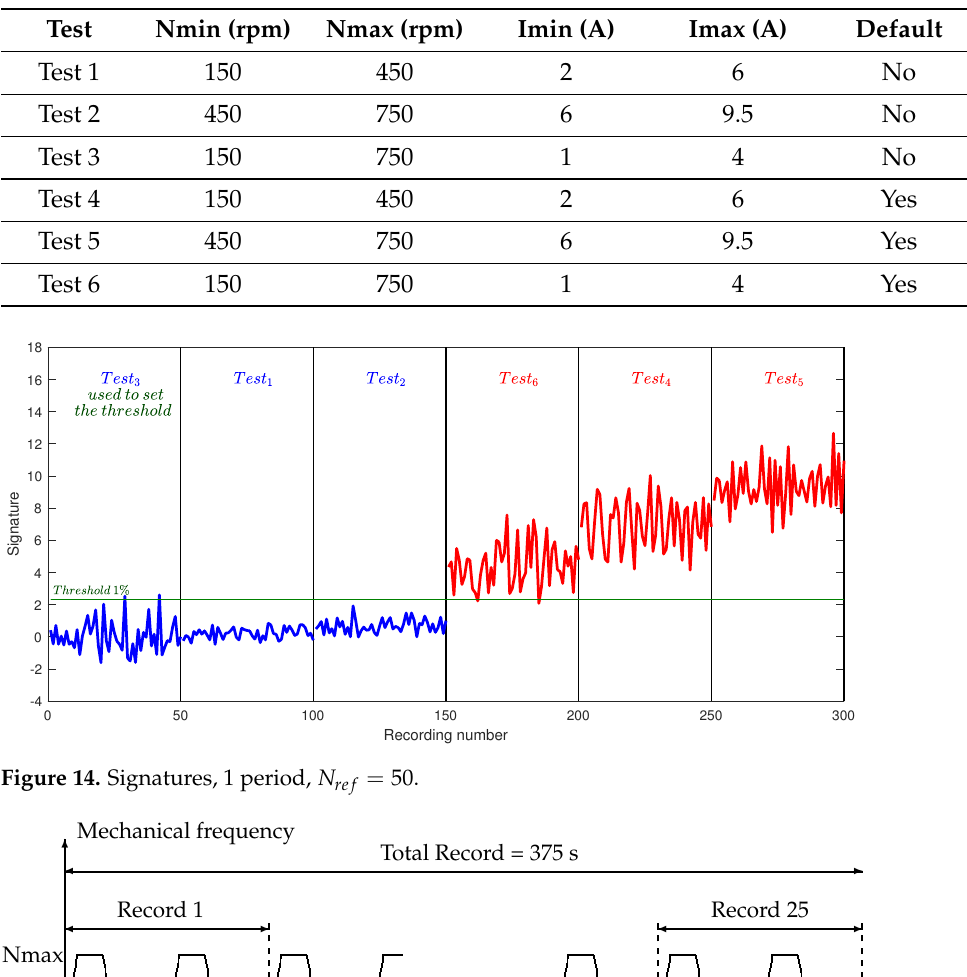
Figure 13. Speed profile for experimental tests. Table 2. Tests setup.